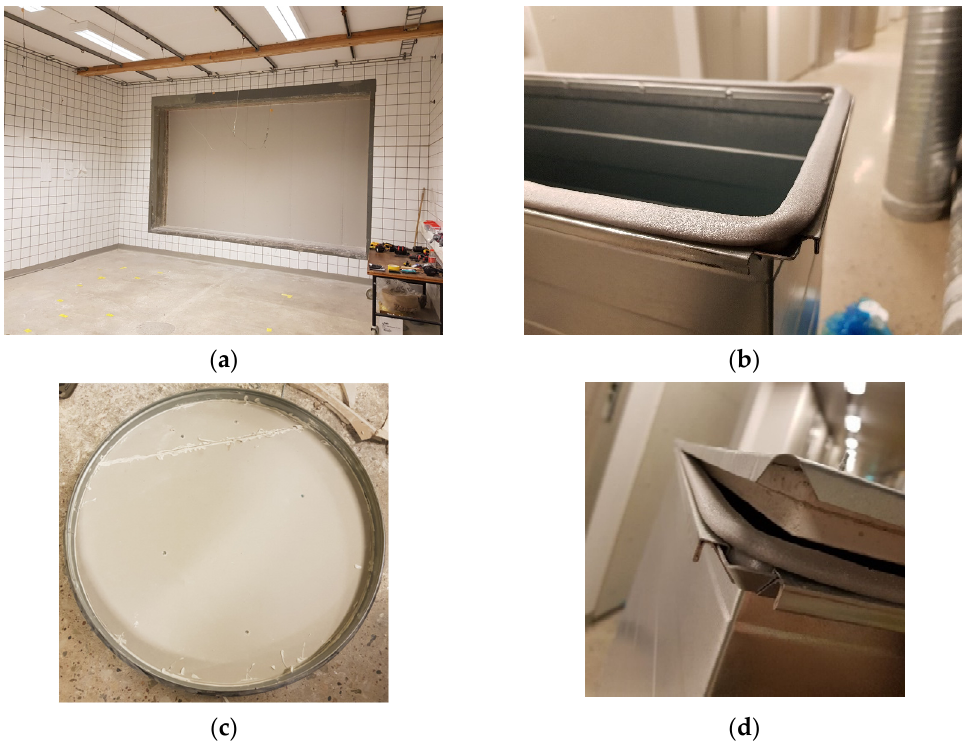
Figure 4. Pictures from the measurements in [2] : ( a ) The finished mounted wall; ( b ) Foam lining for rectangular duct; ( c ) Cover cap for the circular duct: rubber lining, gypsum boards and sealant around the border; ( d ) Cover cap for the rectangular duct: foam lining and gypsum boards.